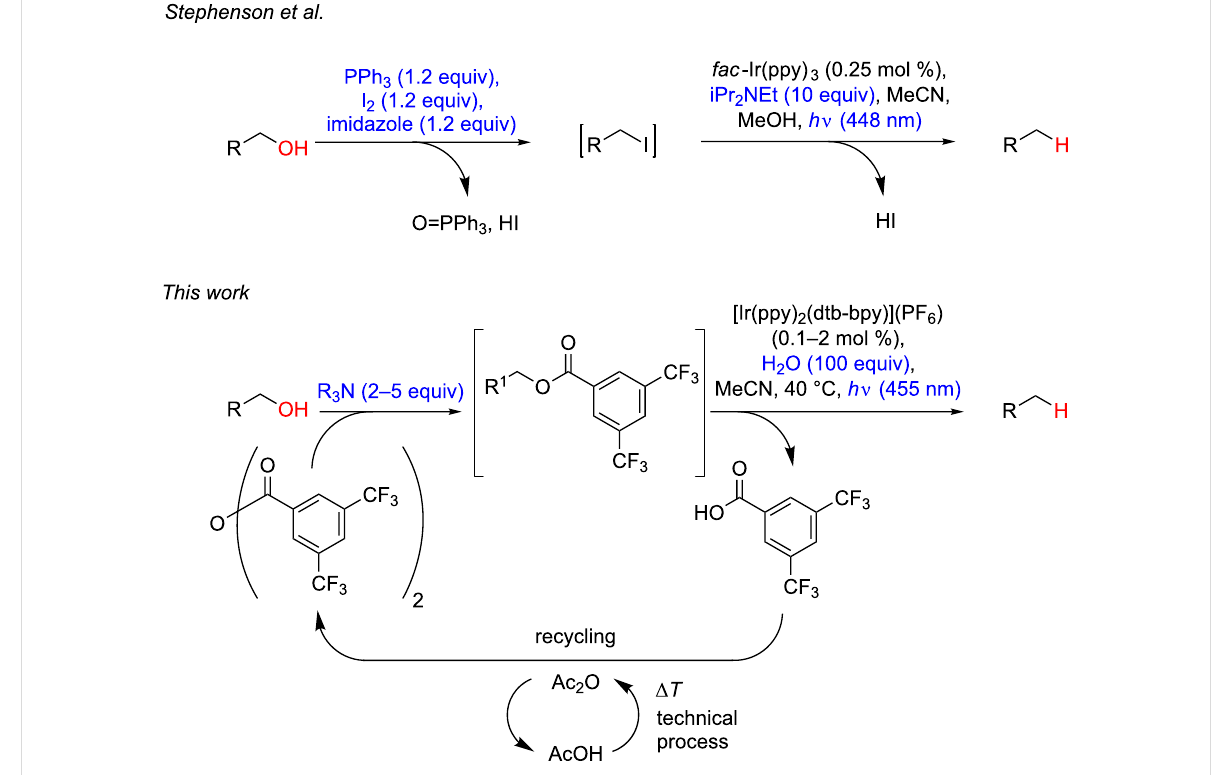
Scheme 1: Strategies for the visible light-catalysed deoxygenation of alcohols (reagents needed in (over-)stoichiometric quantities are depicted in